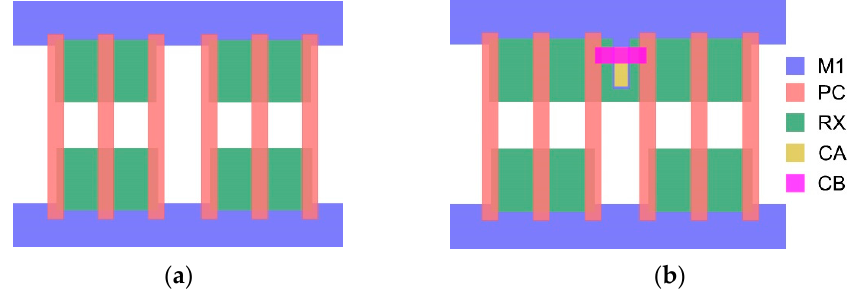
Figure 5. ( a ) Design using double diffusion breaks for the active region of the PFETS, ( b ) design using the CnRx construct to keep the PFET diffusion continuous. Note the inclusion of the T-shape structure that allows the polysilicon to be tied to the respective VDD